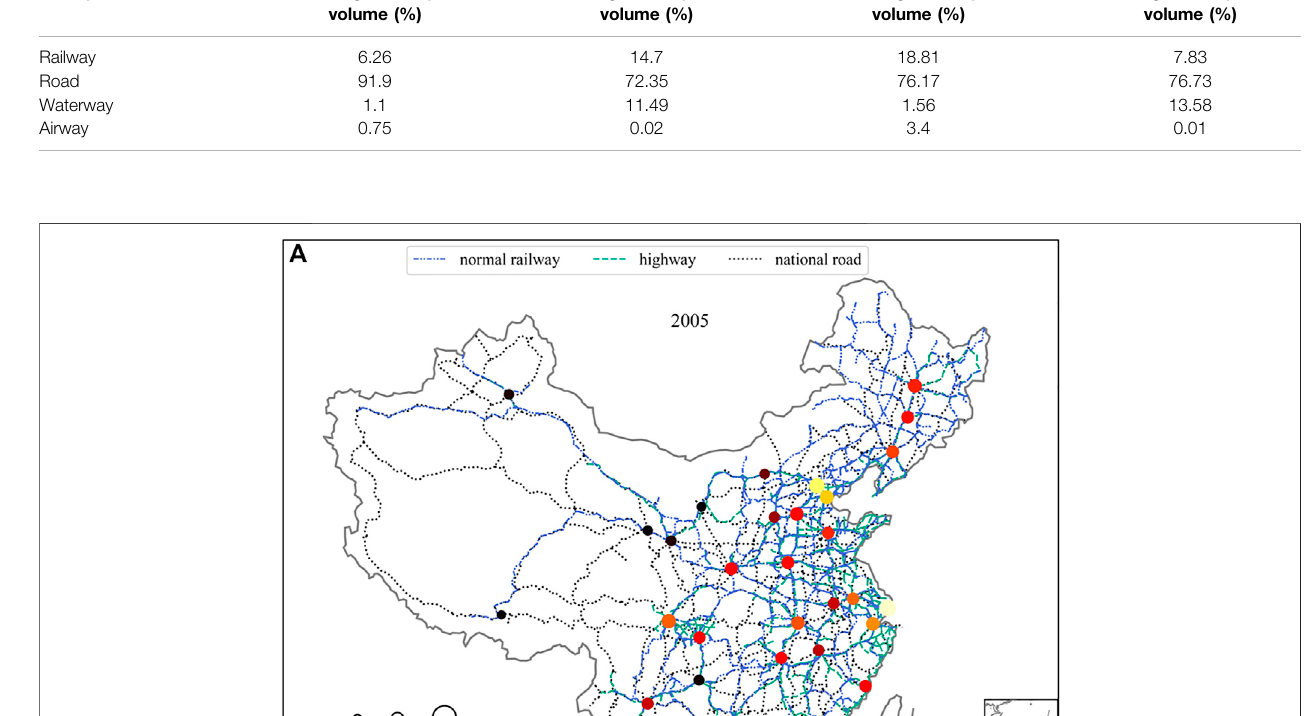
Frontiers in Physics |